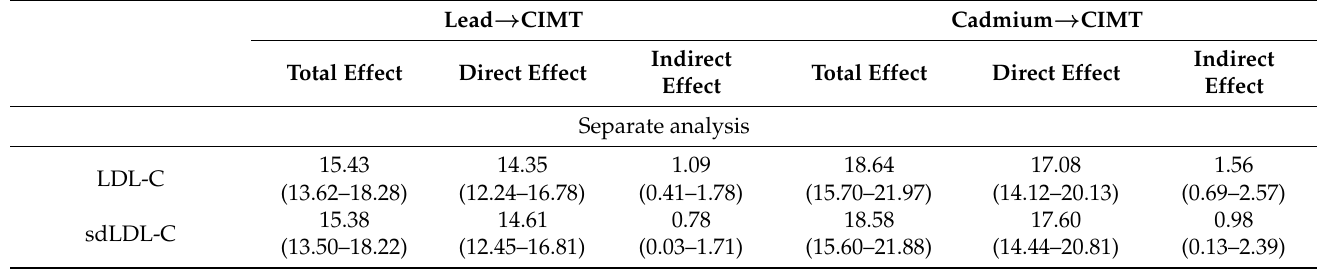
Table 5. The direct, indirect, and total effects (95% CI) of ln-heavy metals ( µ g/g creatinine) on CIMT ( µ m) when controlling the mediator of lipoprotein profiles (mg/dL) in the structural equation